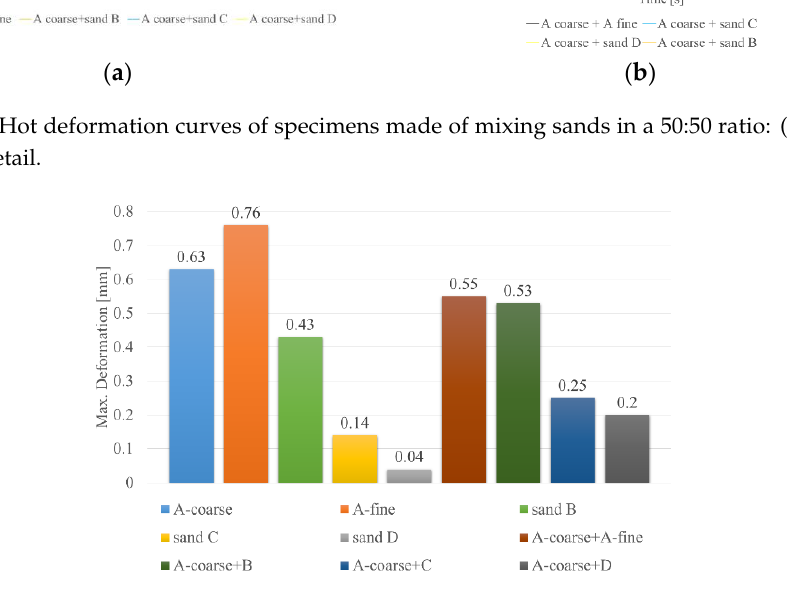
Figure 19. Maximal deformation of tested sands.